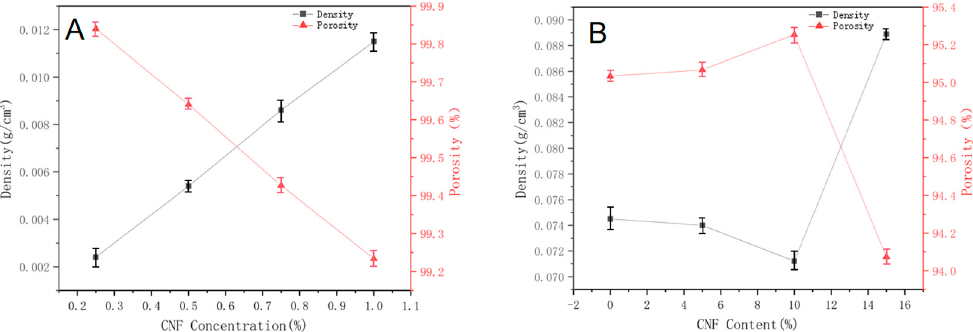
Figure 7. Variations in density and porosity of CNF aerogel ( A ) and the composite cellulose aerogel ( B